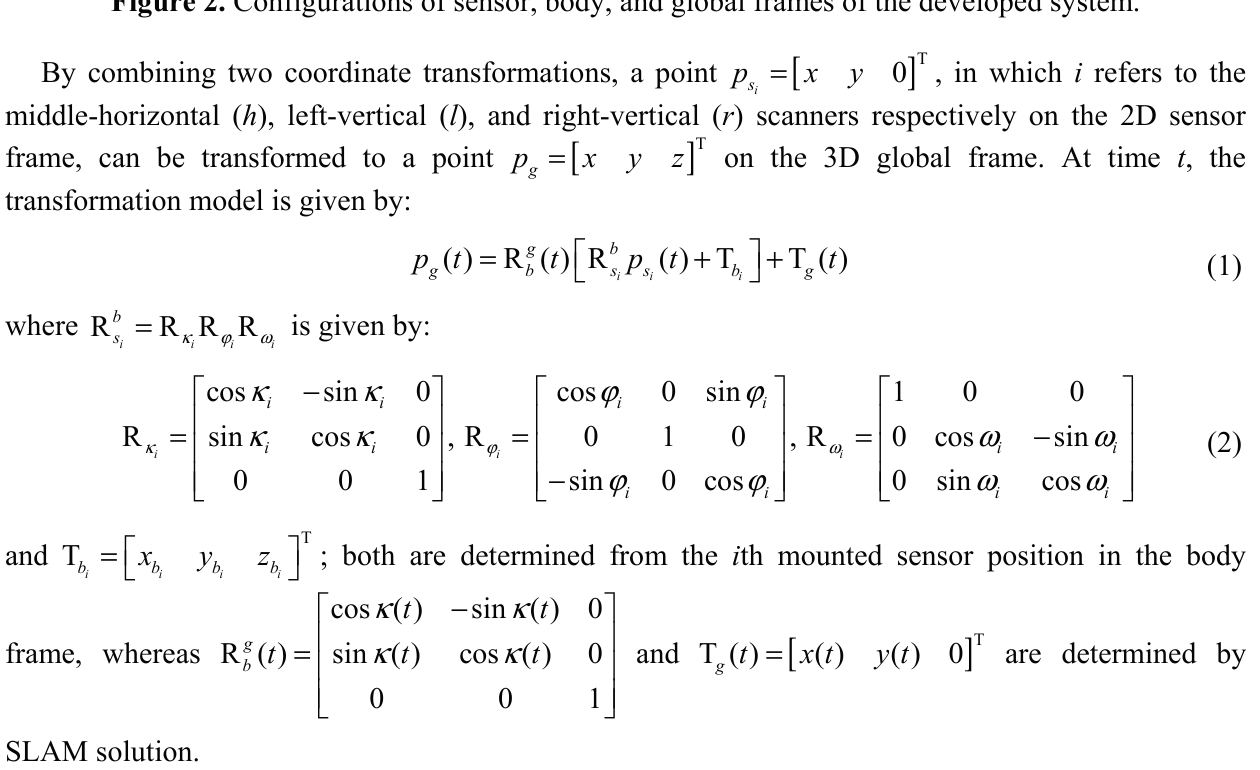
Figure 2. Configurations of sensor, body, and global frames of the developed